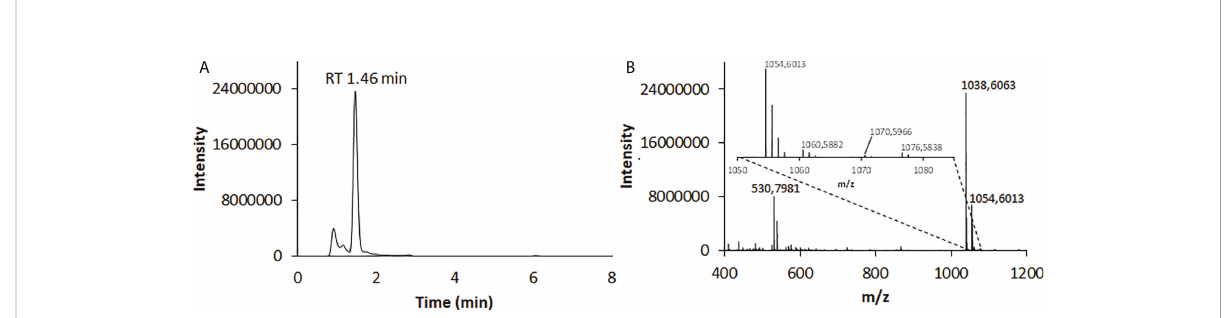
FIGURE 5 Methanolic-water soluble extract of P. borbonicum . LC-MS chromatogram monitored within the mass window m/z 1038-1039 Da (A) and mass spectrum for peak at 1.46 min (B)